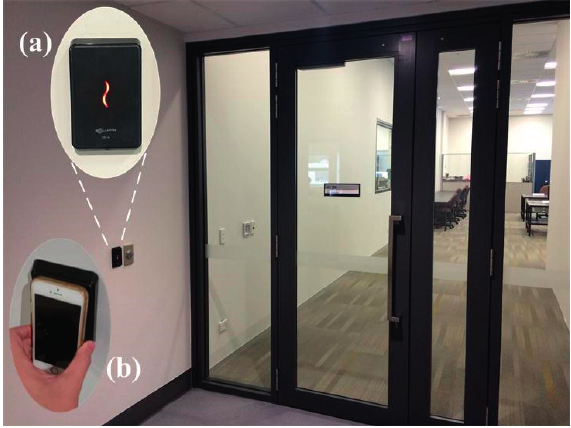
Figure 4. Access control system ( a ) Access card reader ( b ) Phone position against